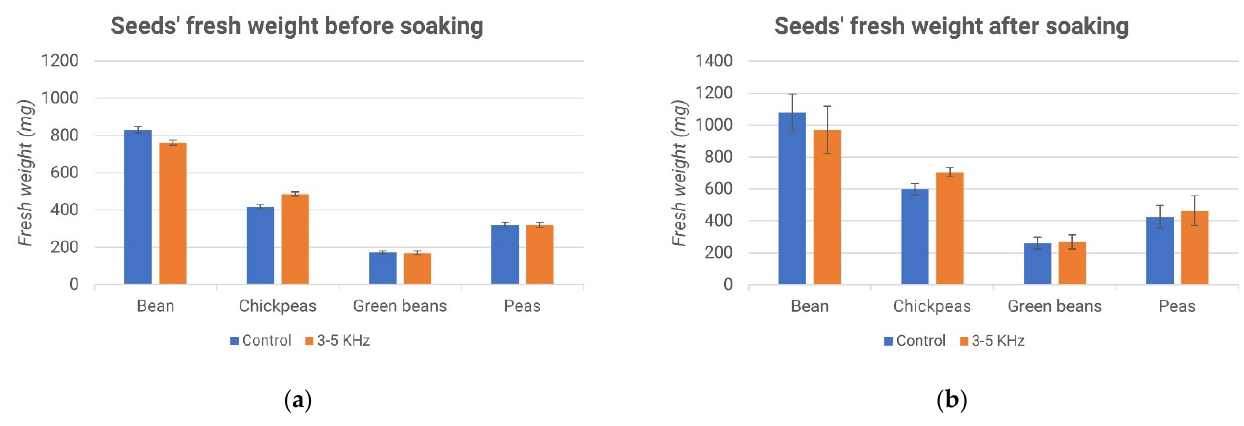
Figure 16. Seeds’ fresh weights before soaking ( a ) and after soaking ( b ).